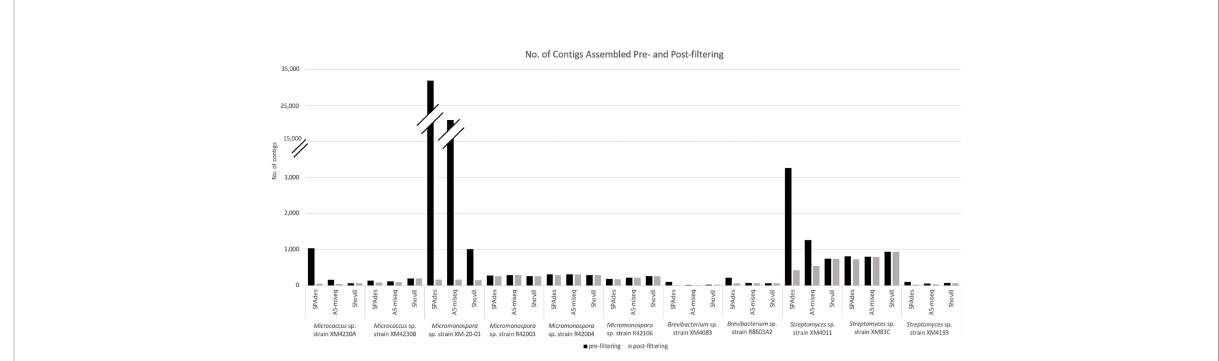
FIGURE 3 Total number of contigs assembled pre- and post- fi ltering for contamination and spillover.